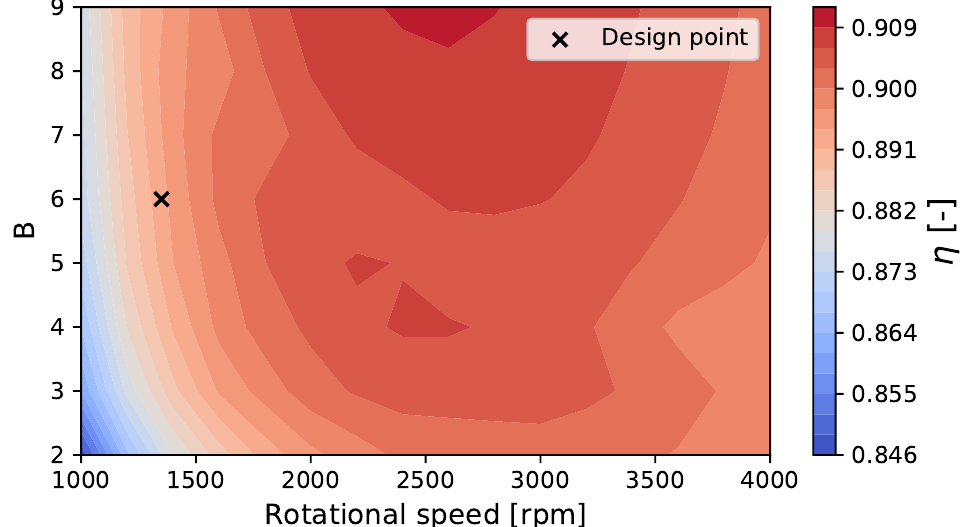
Figure 11. Sensitivity analysis of propeller efficiency in the design procedure to variations in rpm and the number of